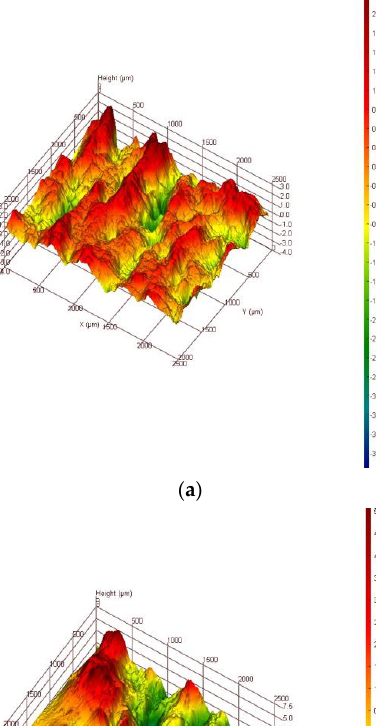
Figure 4. Surface topographies: ( a ) Sample 13, ( b ) Sample 15, and ( c ) Sample 6.